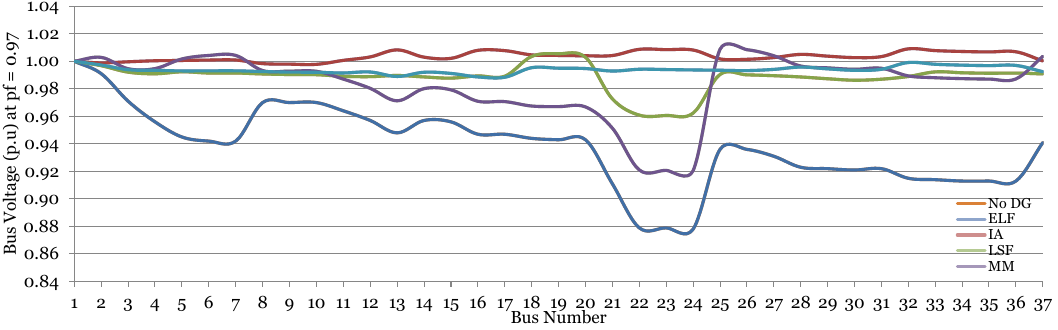
Figure 10. Voltage profile for 37 node system with different methods (pf = 0.97).